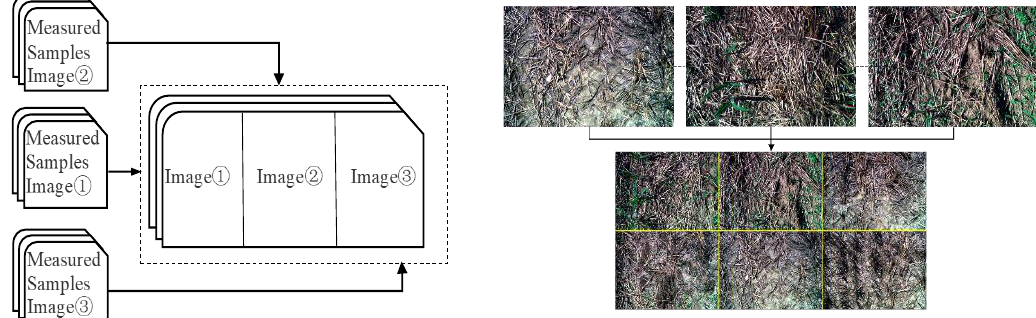
Figure 2. Partition splicing of sample points.